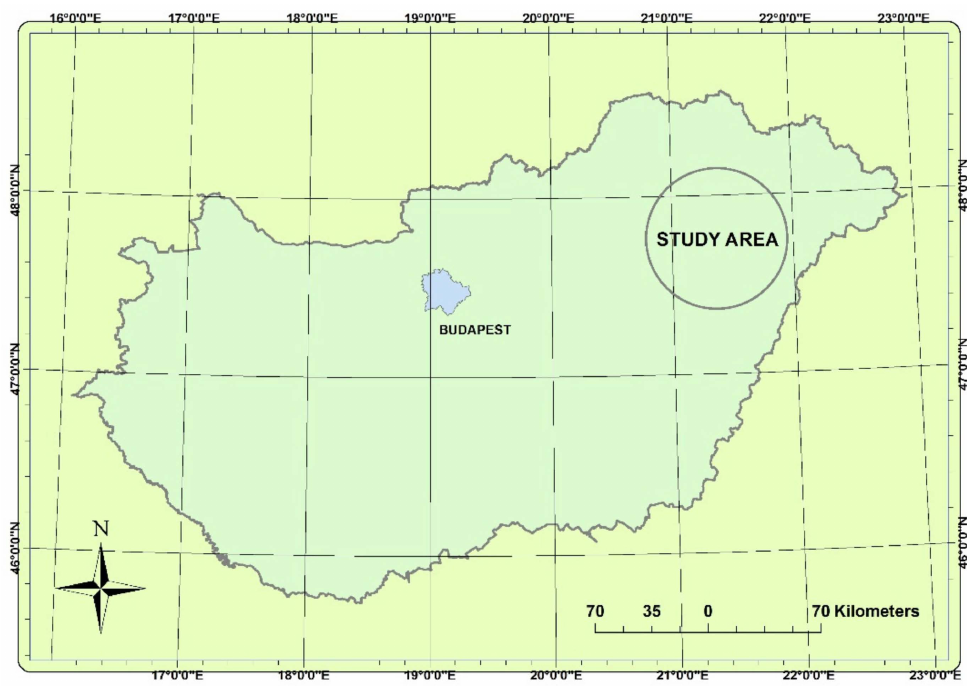
Figure 1. Map of the study area within